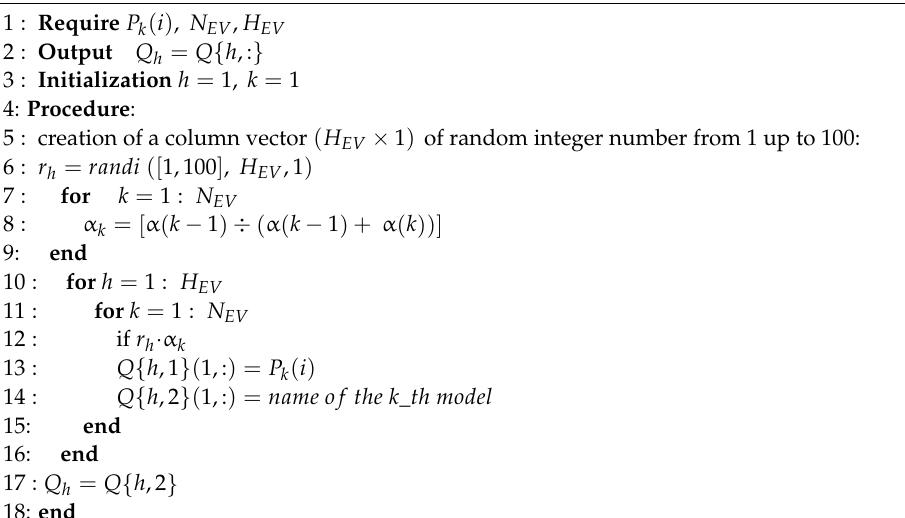
Algorithm 2 creation of the EVs’ queue to be